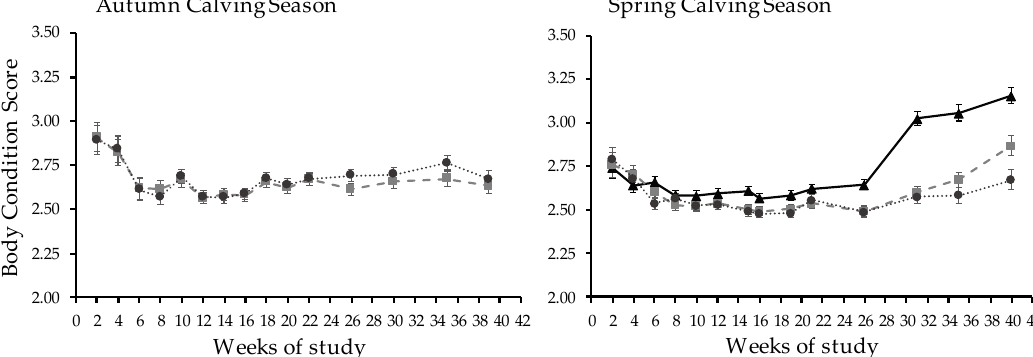
Weeks of study Figure 2. Milk (L/day), fat, and protein (kg/day) yield per cow in autumn ( A – C ) and spring ( D – F ) Figure 2. Milk (L/day), fat, and protein (kg/day) yield per cow in autumn ( A – C ) and spring ( D – F ) Figure 2. Milk (L/day), fat, and protein (kg/day) yield per cow in autumn ( A – C ) and spring ( D – F ) Figure 2. Milk (L/day), fat, and protein (kg/day) yield per cow in autumn ( A – C ) and spring ( D – F ) Figure 2. Milk (L/day), fat, and protein (kg/day) yield per cow in autumn ( A – C ) and spring ( D – F ) calving seasons in confined ( ) and mixed systems with low ( ) or high ( ) environ ‐ calving seasons in confined ( ) and mixed systems with low ( ) or high ( ) environ ‐ calving seasons in confined ( ) and mixed systems with low ( ) or high ( ) environ ‐ calving seasons in confined ( ) and mixed systems with low ( ) or high ( ) environ ‐ calving seasons in confined ( Animals 2023 , 13 , x mental exposure during complete lactation. mental exposure during complete lactation. mental exposure during complete lactation. mental exposure during complete lactation. exposure during complete lactation. The BCS patterns during complete lactation adjusted for BCS at calving (3.05 ± 0.27) The BCS patterns during complete lactation adjusted for BCS at calving (3.05 ± 0.27) The BCS patterns during complete lactation adjusted for BCS at calving (3.05 ± 0.27) The BCS patterns during complete lactation adjusted for BCS at calving (3.05 ± 0.27) were affected by WOS for all treatments (Figure 3) but did not differ between treatments were affected by WOS for all treatments (Figure 3) but did not differ between treatments were affected by WOS for all treatments (Figure 3) but did not differ between treatments were affected by WOS for all treatments (Figure 3) but did not differ between treatments (2.67 vs. 2.69 ± 0.02). (2.67 vs. 2.69 ± 0.02). (2.67 vs. 2.69 ± 0.02). (2.67 vs. 2.69 ± 0.02).